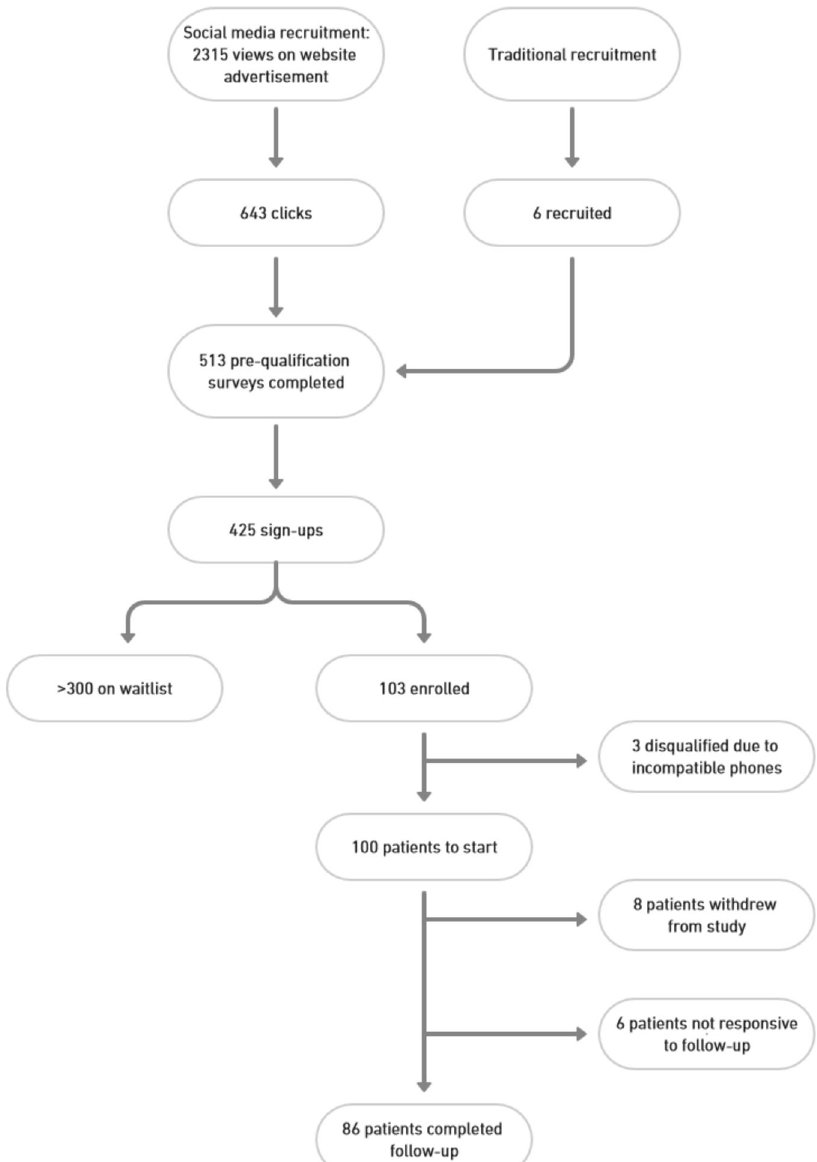
Fig. 1 DeTAP recruitment and enrollment fl ow. Participants were recruited through both traditional and social media methods. This fi gure outlines the fl ow of participant recruitment and